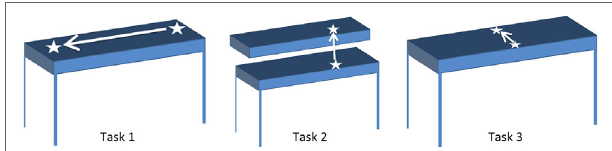
FigUre 2 | Start and end positions for Tasks 1–3. White arrow indicates direction of motion from start to end position for each